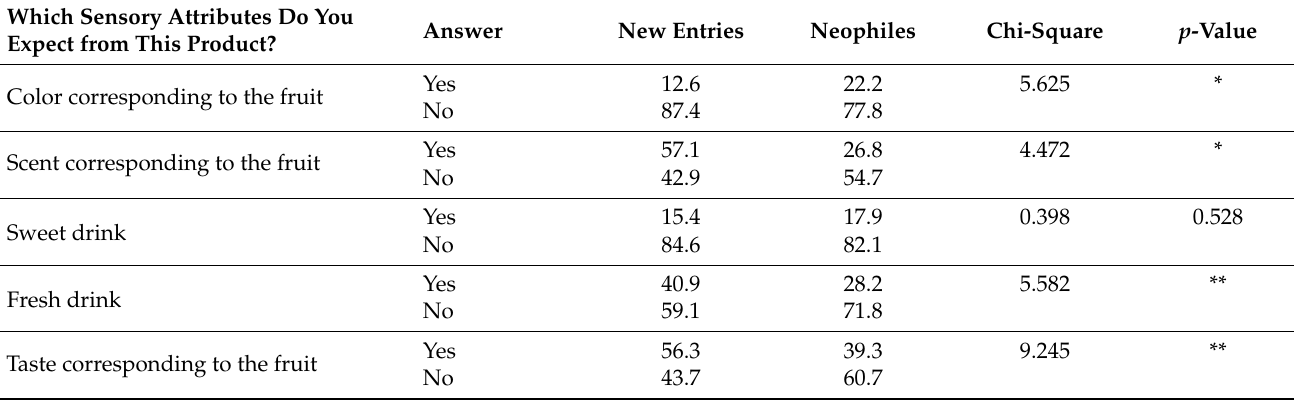
Table 4. Expectations of new entries ( n = 253) and neophiles ( n = 118) in terms of sensory characteristics of fruit wine. Which Sensory Attributes Do You Expect from This Product? Color corresponding to the